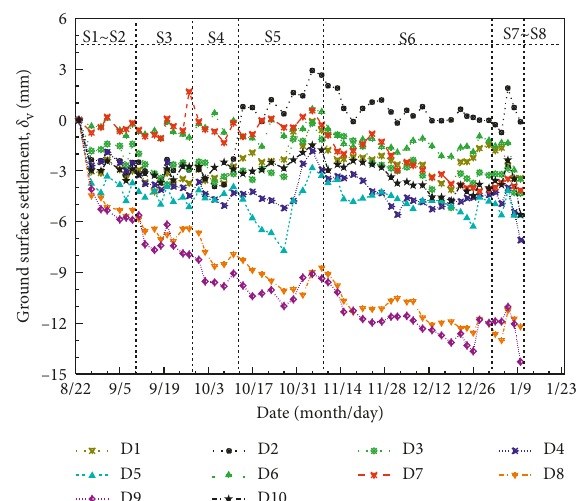
Figure 12: Relationship between ground settlement versus